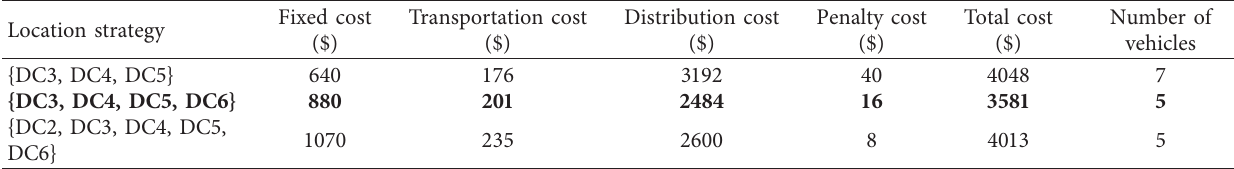
Table 5: Result comparison among different location strategies.